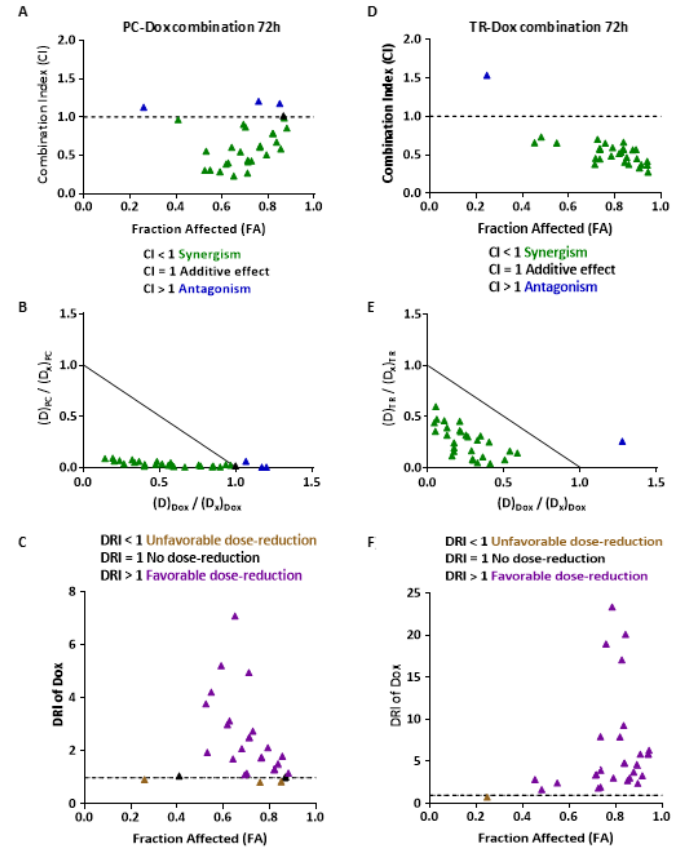
Figure 9. Determination of the combinatory effect of Pituranthos chloranthus (PC) and Teucrium ramosis- simum Desf. (TR) extracts with doxorubicin (Dox) on MES-SA/Dx5 cell viability. Multidrug-resistant MES-SA/Dx5 cells were pretreated with increasing PC or TR concentrations for 24 h. Thereafter, the cells were treated with increasing Dox amounts for the last 48 h. Growth inhibition level